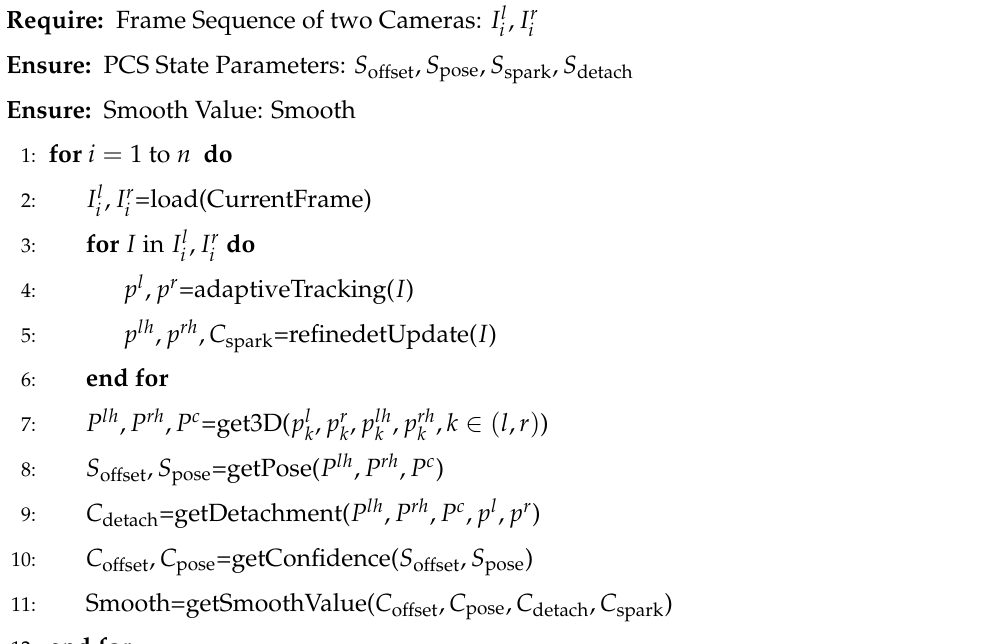
Algorithm 1 PCS State Analysis Algorithm